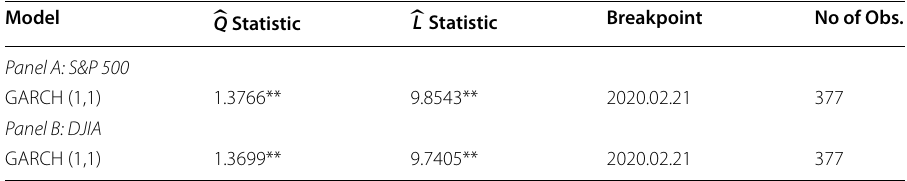
Table 9 reports the results of modified CUSUM and LM tests for structural breaks in volatilites of both S&P 500 and DJIA over the period January 1st, 2019 to June 30th, 2020. The modified CUSUM test allows for multiple structural breaks while the modified LM test only allows for a single break. The bandwidth is selected by cross validation. L is the modified LM test statistic statistic and (cid:31) **indicates significance at the 5% level